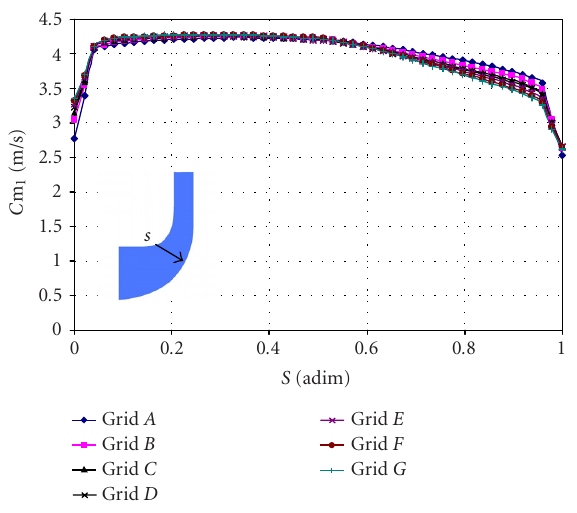
Figure 6: Influence of turbulence model on the calculated pump